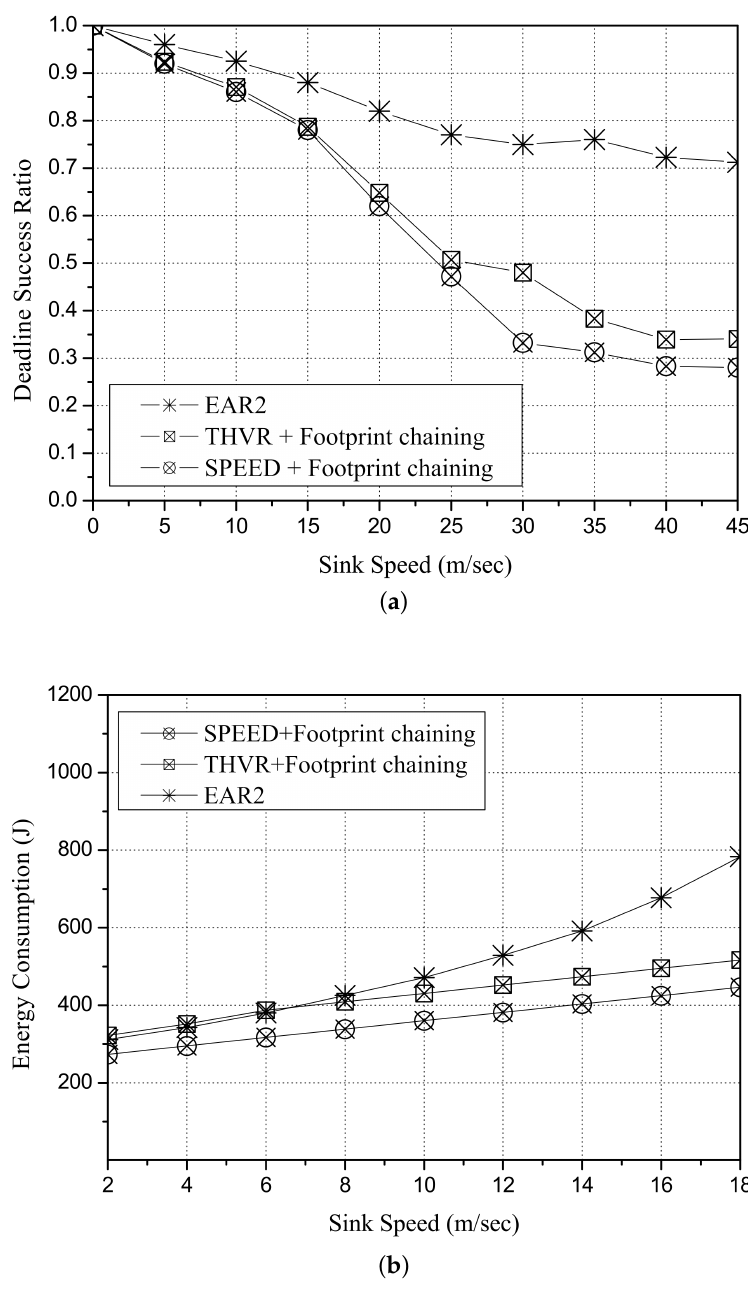
Figure 5. Performance comparison of EAR2 with the existing schemes SPEED and THVR according to sink speed: ( a ) deadline success ratio and ( b ) energy